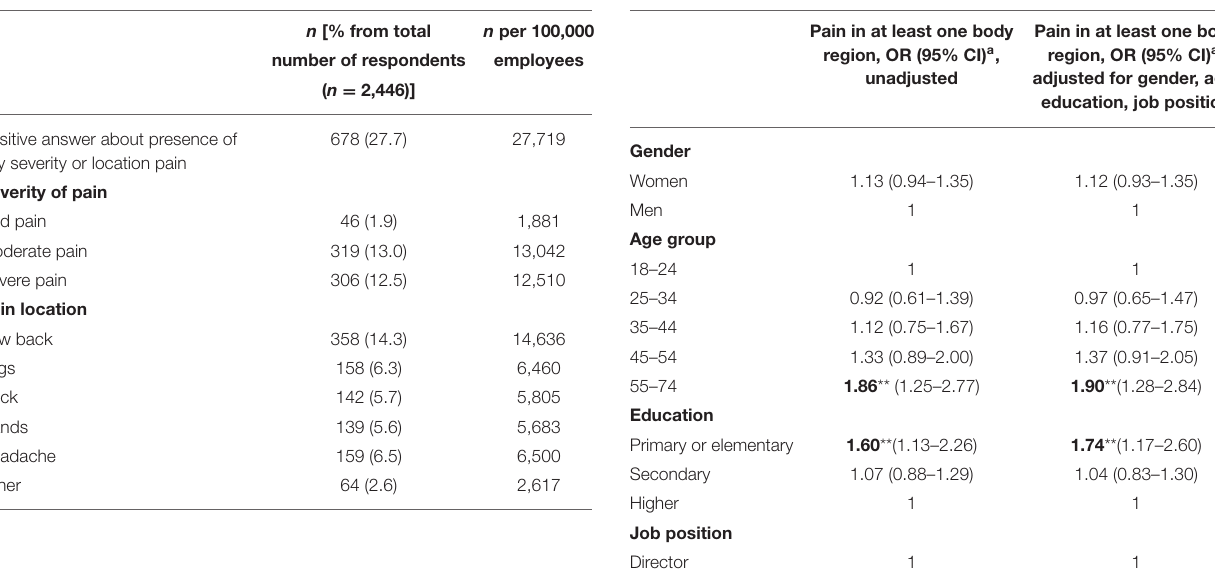
TABLE 3 | Prevalence of self-reported pain lasting longer than 3 days during the last year according to pain location and